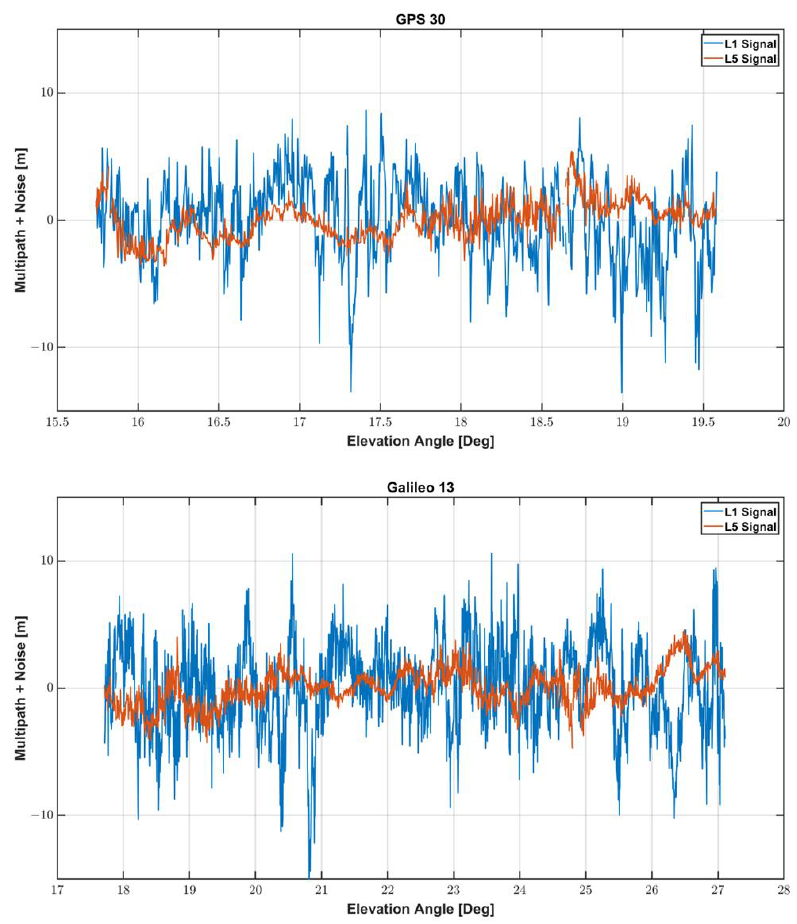
Figure 7. Multipath error and noise at GPS 30 and GAL 13 satellites in L1 and L5 Frequency. Table 4. Multipath error and noise results.